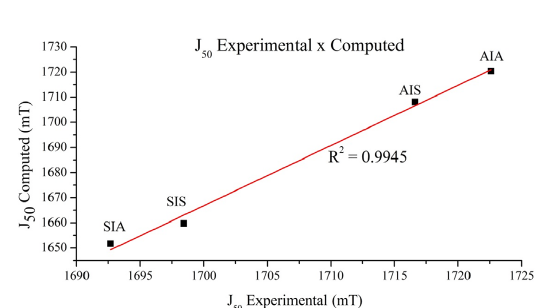
Figure 3. Experimental and computed J in two , and J * for rolling direction (0°) and calculated values of fEa and J 15/60 50